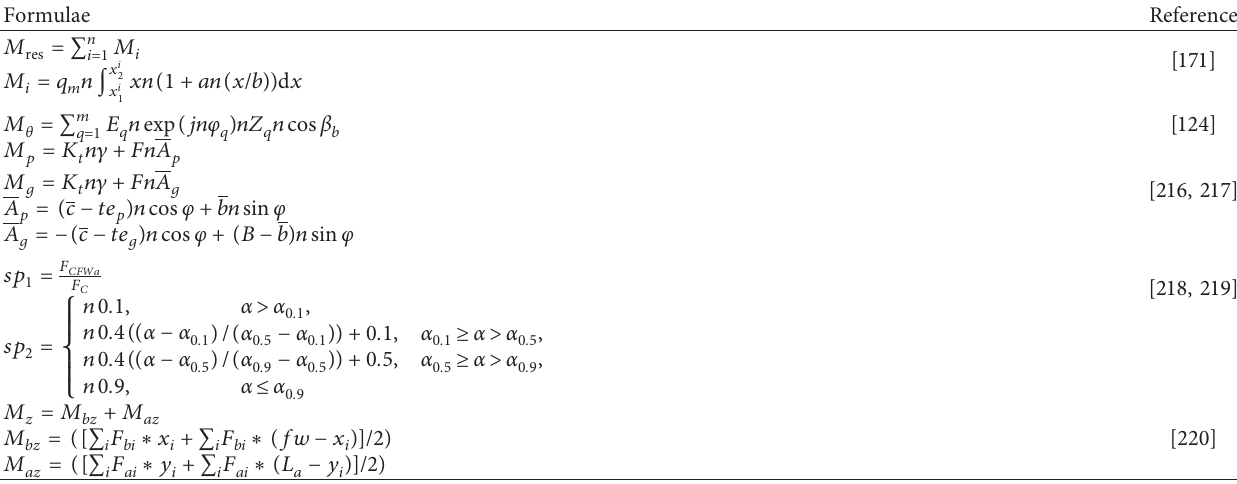
Table 5: Formulae for shuttling forces and